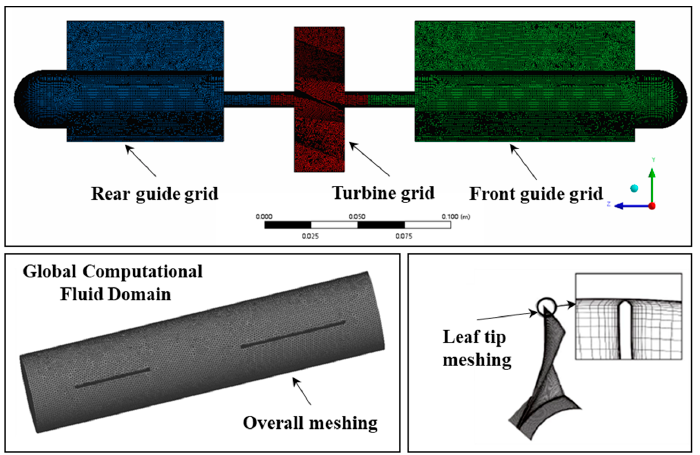
Figure 5. Turbine flowmeter profile domain and boundary condition model with boundary conditions.